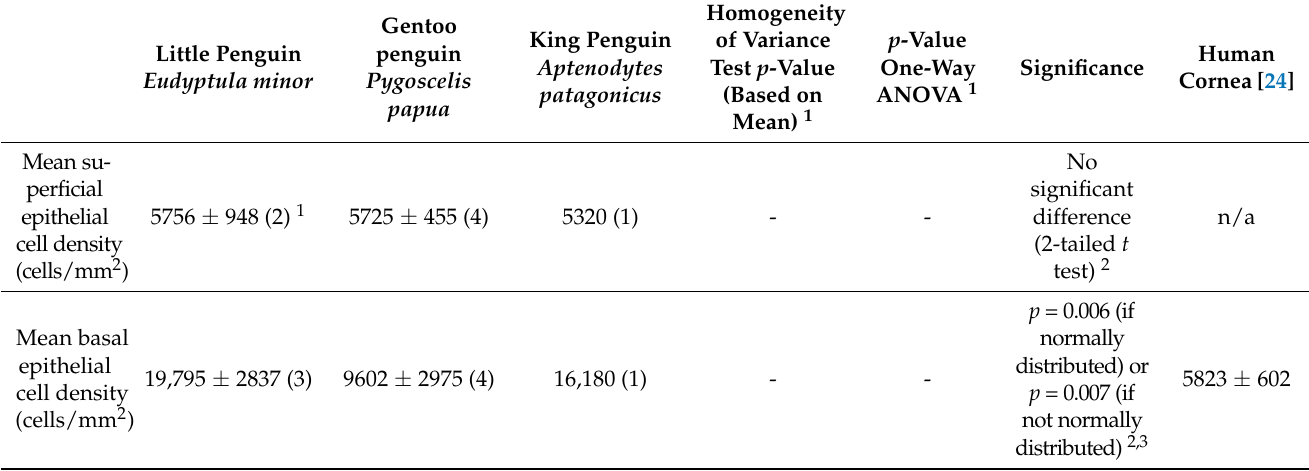
Table 2. Cell densities in different layers of the penguin cornea (mean ± standard error of the mean). The total number of eyes examined in each layer of the cornea is noted in brackets. The gentoo penguin Pygoscelis papua tended to have a lower stromal cell density regardless of the depth at which the density was examined; the difference reached statistical significance versus the little penguin Eudyptula minor in the anterior and mid-stroma and significantly less than the king penguin Aptenodytes patagonicus in the posterior stroma. It also had a significantly less dense basal corneal epithelium than the little penguin. There was no significant difference in superficial epithelial or endothelial cell density between